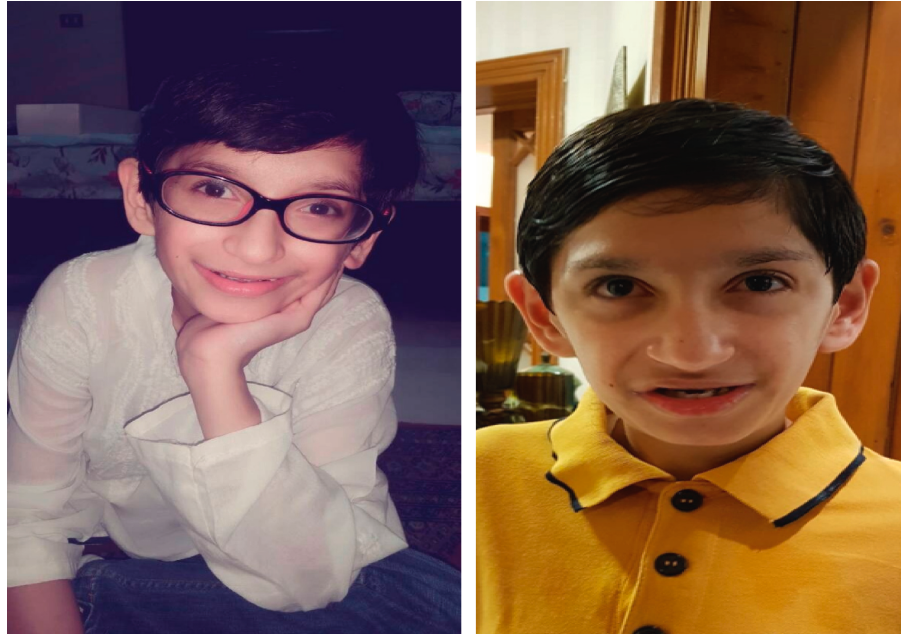
Figure 1: Dysmorphic features in the patient, including low set ears, prominent nose, deep-set eyes, and a relatively large mouth, consistent with those reported (MIM#615541) (https://www.omim.org/clinicalSynopsis/615541).